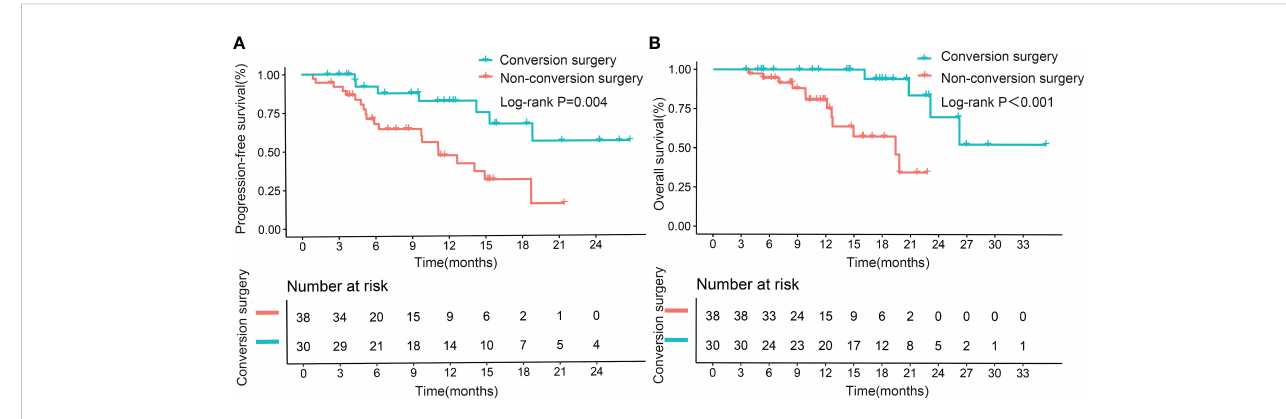
FIGURE 5 Kaplan – Meier curves for progression-free survival (A) and overall survival (B) in patients with early tumor response, based on successful conversion